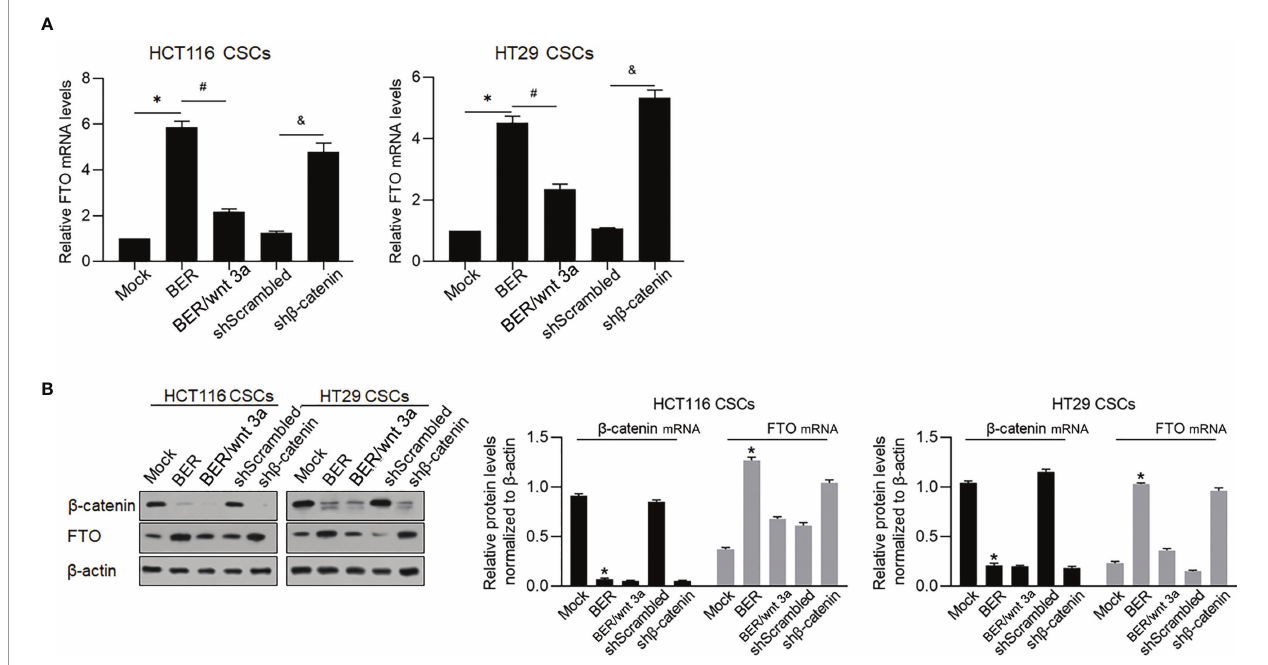
FIGURE 10 | Berberine upregulated FTO via downregulating b -catenin. After Berberine treatment, activating wnt signaling or knockdown b -catenin for 48 h, FTO mRNA levels (A) and protein levels (B) were measured. *p < 0.05, vs. mock group; # p < 0.05, vs. Berberine-treated group; & p < 0.05, vs. shScrambled